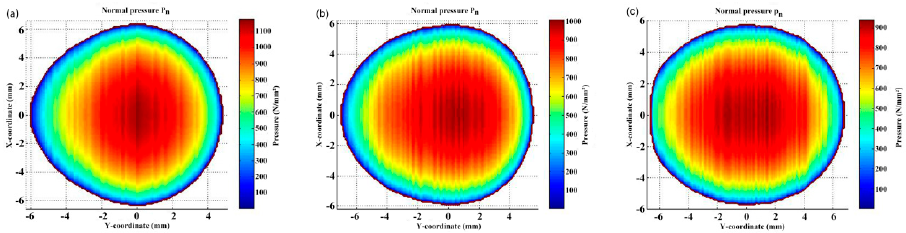
Figure 20. Designed wheel matching CHN60. ( a ) Lateral displacement 0 mm; ( b ) Lateral displacement 3 mm; ( c ) Lateral displacement 6 mm.